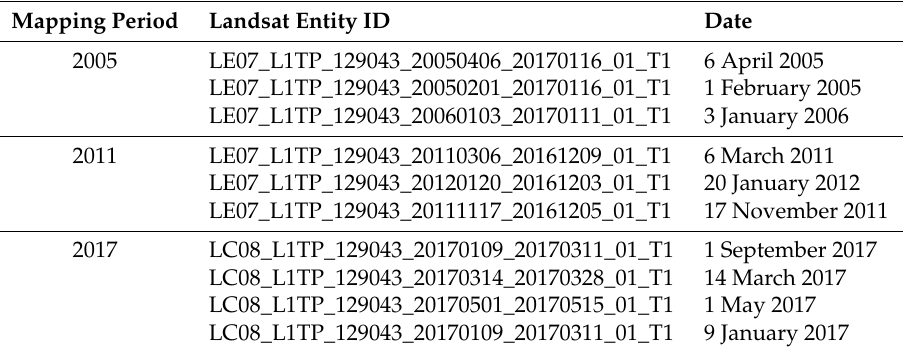
Table 1. Landsat images information for the LCZ